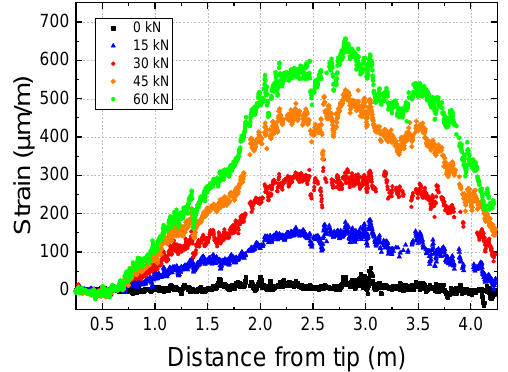
Fig. 17. Maximum surface microstrain measurements recorded with implanted optical fibre along the blade from tip (left) to root (right), during 5 loading tests to different levels up to 60 kN.